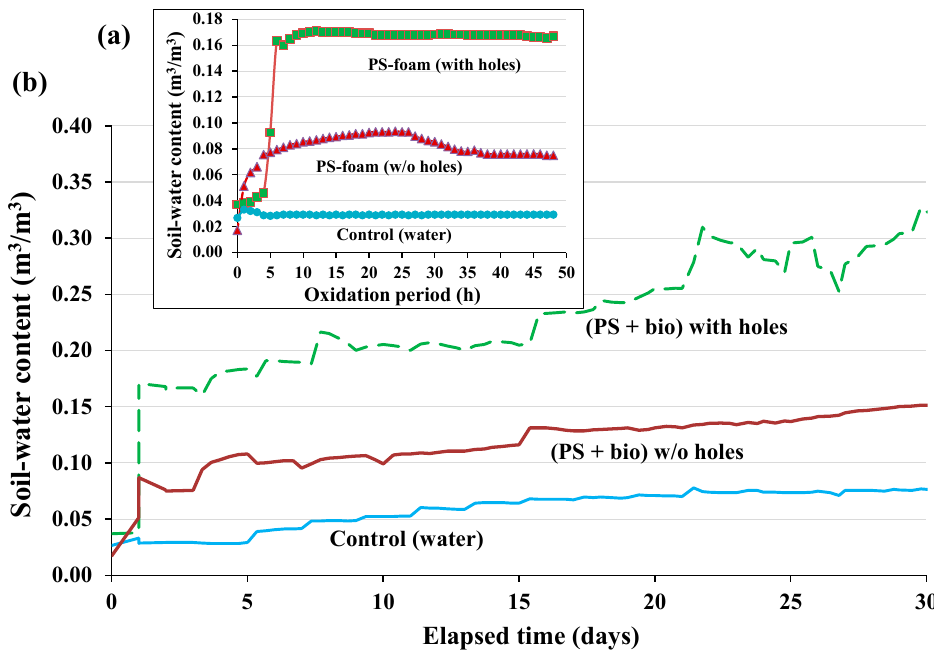
Figure 2. Change in volumetric water content (VWC) in soil columns with or without using vertical holes at 25 cm depth during ( a ) persulfate oxidation (PS) for two days, and ( b ) oxidation followed by bioaugmentation (PS + bio) for 28 days (4 weeks). Note that foam was sprayed onto the soil surface. Control indicates the treatment of water in soil columns with holes.